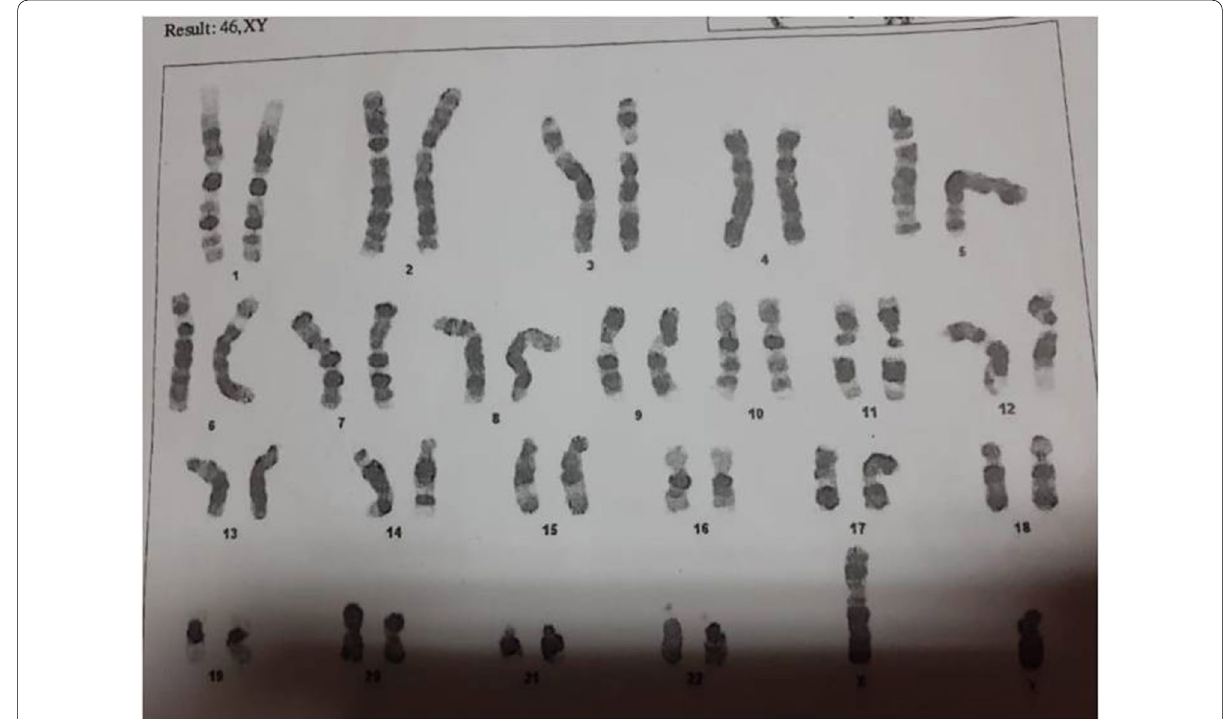
Fig. 4 Karyotyping of the patient revealed male genotype